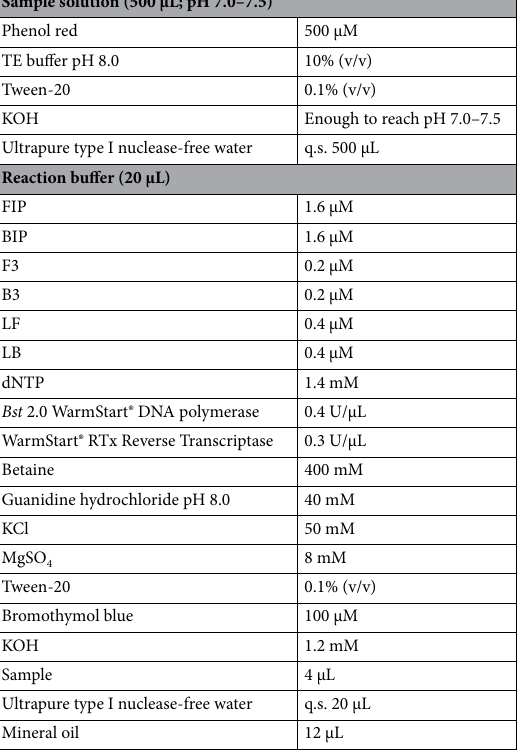
Table 2. Summary of sample solution and reaction buffer